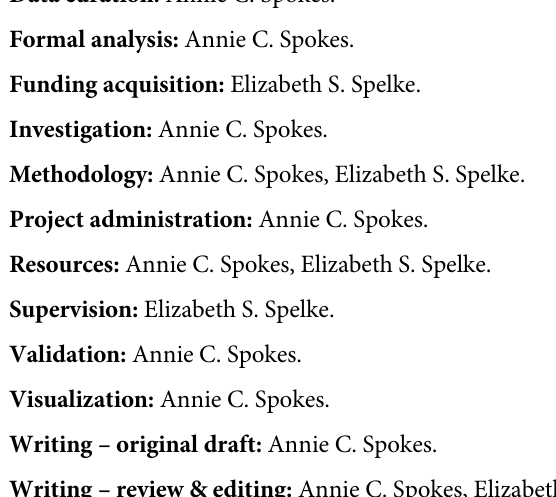
S1 Fig. Visual form analysis task images. All images in trial order for visual form analysis tri- als in practice and test. (PDF) S2 Fig. Children’s performance in the visual form analysis task by recipient. (A) 4.5-year- old children ( n = 24) played more trials for kin (sibling, parent) than non-kin (friend, stranger), (B) answered correctly on more trials, and (C) played the game for marginally longer ( (cid:3) P < 0.05, ~ P = 0.083). (D) 5.5-year-old children ( n = 24) played roughly the same number of trials for kin (sibling, parent) and non-kin (friend, stranger), (E) answered correctly on similar number of trials, and (F) played the game for a similar amount of time. (TIF) S1 Table. Children’s performance in the visual form analysis task. 4.5- and 5.5-year-old children’s mean (and standard deviation) performance in the visual form analysis task when playing for a sibling, parent, friend, or